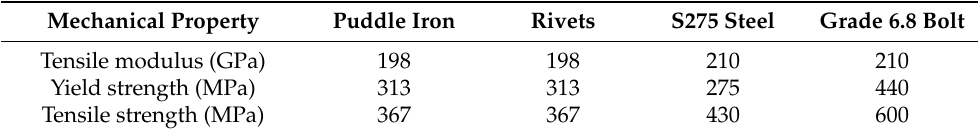
Table 3. Mechanical properties of metallic materials used.